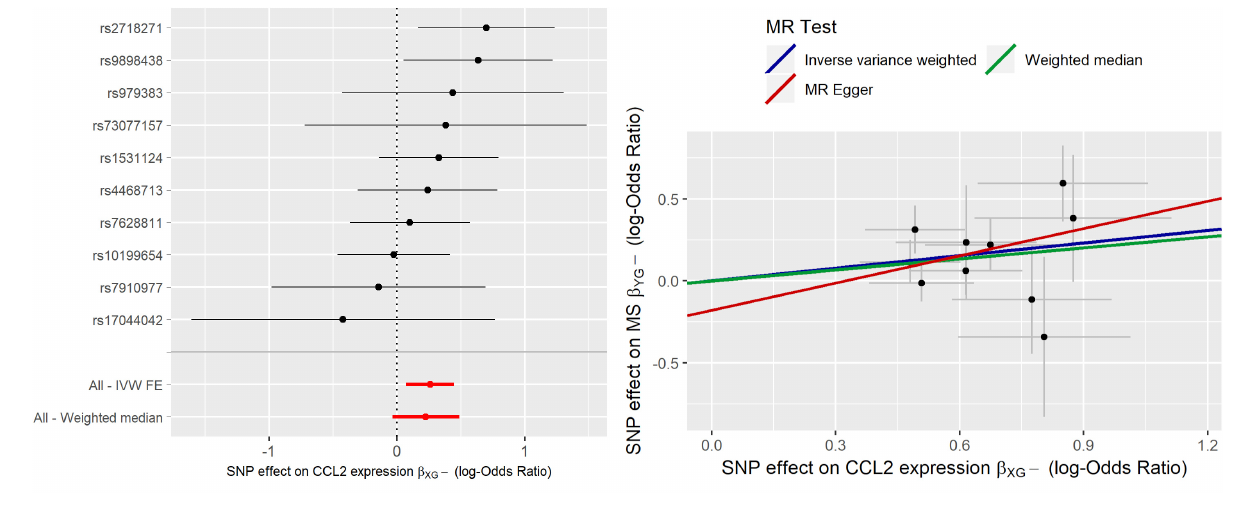
FIGURE 3 | Forest plot and Scatter plot of causal estimates of CCL2 expression in medulla (MEDU) on MS.